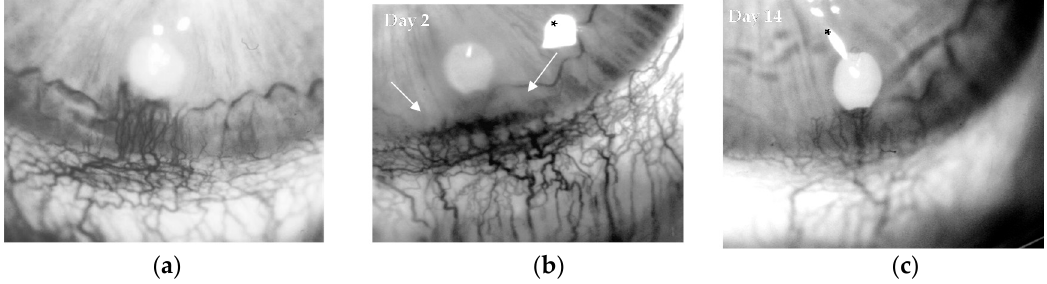
Figure 3. Bradykinin (BK) stimulates angiogenesis through the bradykinin 2 receptor (B2R). Representative images of rabbit corneas implanted with: ( a ) BK (1 μ g/pellet) (panel a, day 14) and ( b ) kallidin (5 μ g/pellet) at day 2 or ( c ) day 14. Asterisks mark flash artifacts. White arrows indicate corneal opacity with loss of corneal clarity and transparency. Original magnification 18 × . Table 1. Assessment of angiogenesis by BK and kallidin in the rabbit cornea assay. Stimulus (Dose/Pellet)